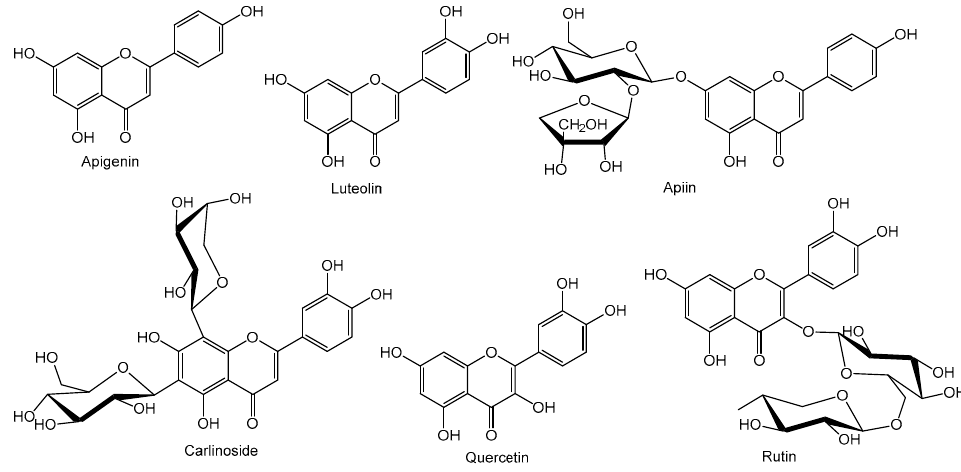
Figure 5. Examples of representative flavones and flavonols.